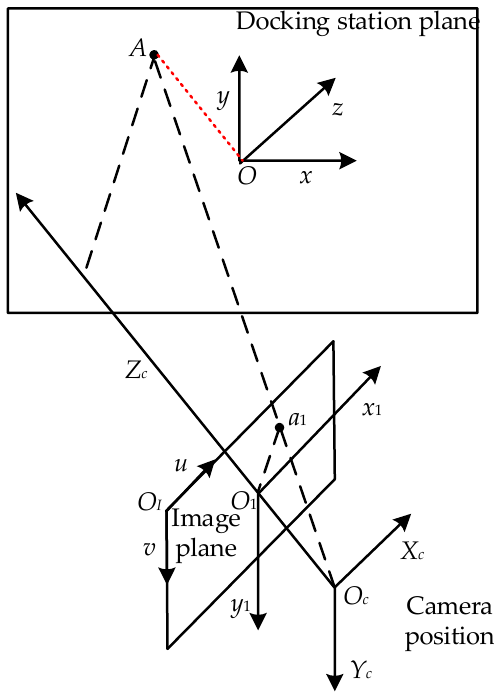
Figure 1. Coordinate systems for the docking station and camera.